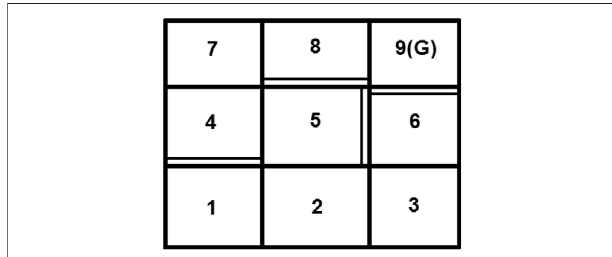
FIGURE 1 | The grid-world